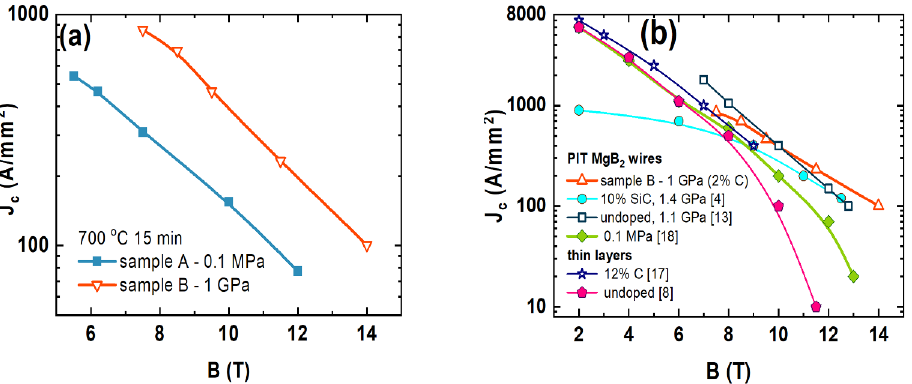
Figure 6. ( a ) Dependence of the perpendicular magnetic field ( B ) on the transport critical current density ( J c ) at 4.2 K for samples A and B and ( b ) for comparison, the results of undoped and doped MgB 2 wires made by using PIT method and thin layers, e.g., C-doping and SiC-doping.